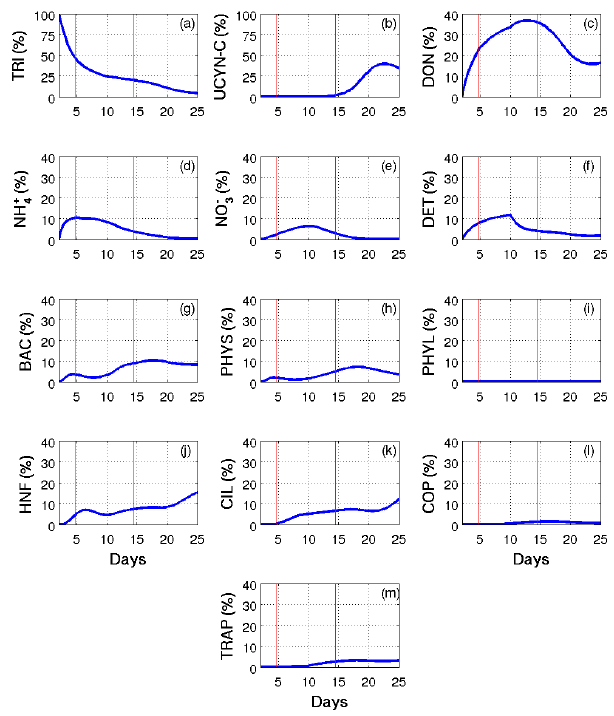
Figure 7. Patterns of change over time of DDN proportion (%) in (a) Trichodesmium (TRI), (b) unicellular N 2 -fixing cyanobacte- ria (Group C) (UCYN-C), (c) dissolved organic nitrogen (DON), (d) ammonium (NH + ), (e) nitrate (NO − ), (f) detrital nitrogen 4 3 (DET N ), (g) heterotrophic bacteria (BAC), (h) small phytoplankton (PHYS), (i) large phytoplankton (PHYL), (j) hetero-nanoflagellates (HNF), (k) ciliates (CIL), (l) copepods (COP) and (m) in traps (TRAP) in SIM E . Red vertical lines distinguish the three periods P0 (before the DIP enrichment), P1 (diatom–diazotroph associa- tions dominate the diazotrophic community) and P2 (unicellular N 2 -fixing cyanobacteria (Group C) dominate the diazotrophic com- munity).